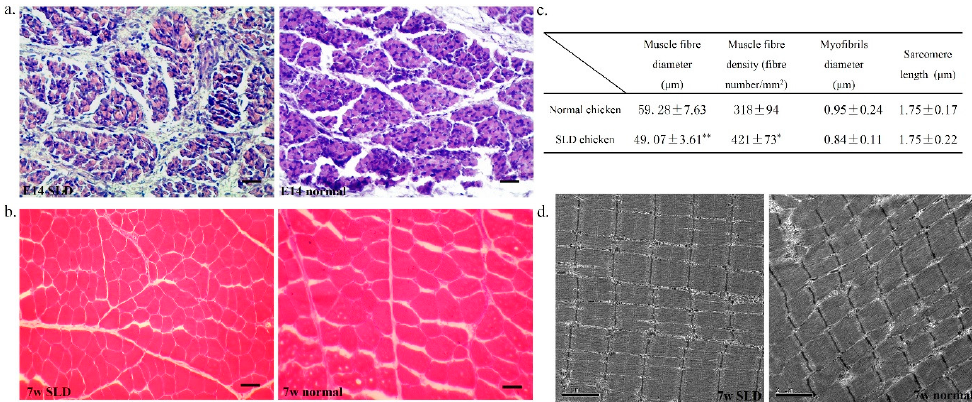
Figure 1. Muscle fiber characteristics in the sex-linked dwarf (SLD) and normal chickens. ( a ) Haematoxylin and eosin (H&E) staining of the leg muscle cross-section from embryo day 14 (E14) SLD ( left ) and normal ( right ) chickens. Bar, 50 µm; ( b ) H&E staining of the leg muscle cross-section from seven weeks (7w) SLD ( left ) and normal ( right ) chickens. Bar, 50 µm; ( c ) Muscle fiber diameter, muscle fiber density, myofibrils diameter and sarcomere length in 7w dwarf and normal chickens. Statistical significance between groups was analyzed by one-sample t tests. * p < 0.05; ** p < 0.01; ( d ) Electron micrograph of a leg muscle cross-section from 7w SLD ( left ) and normal ( right ) chickens. Bar, 2 µm.